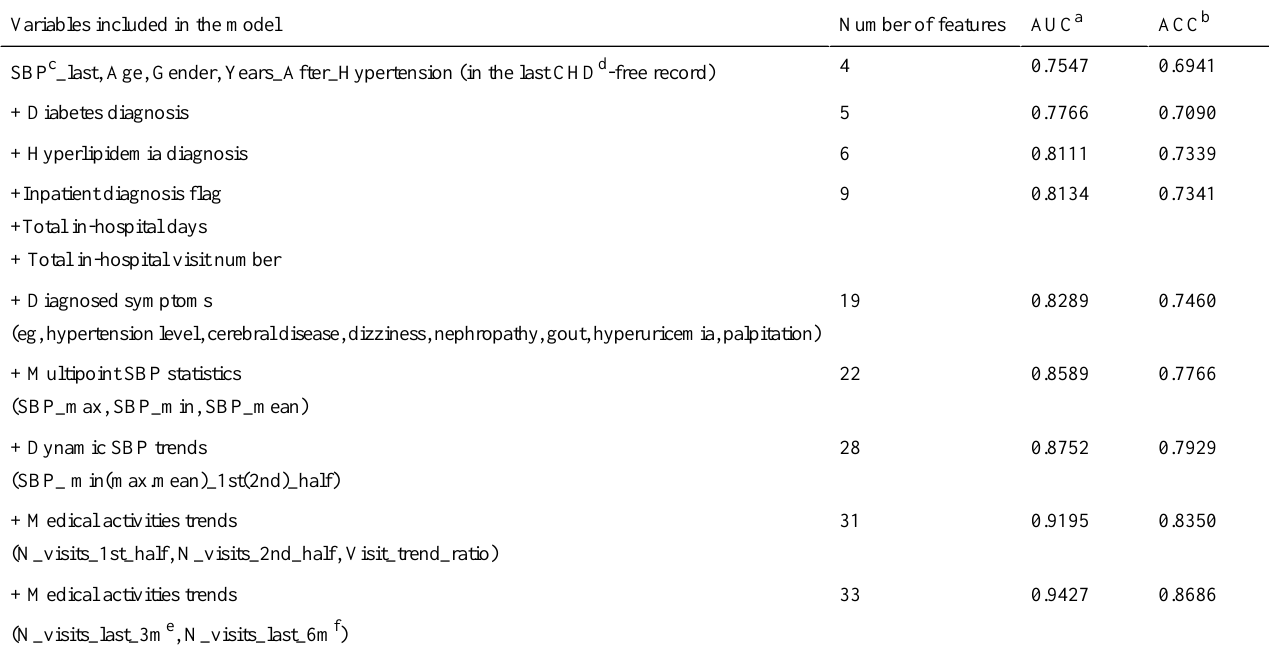
ACC b AUC a Number of featuresVariables included in the model